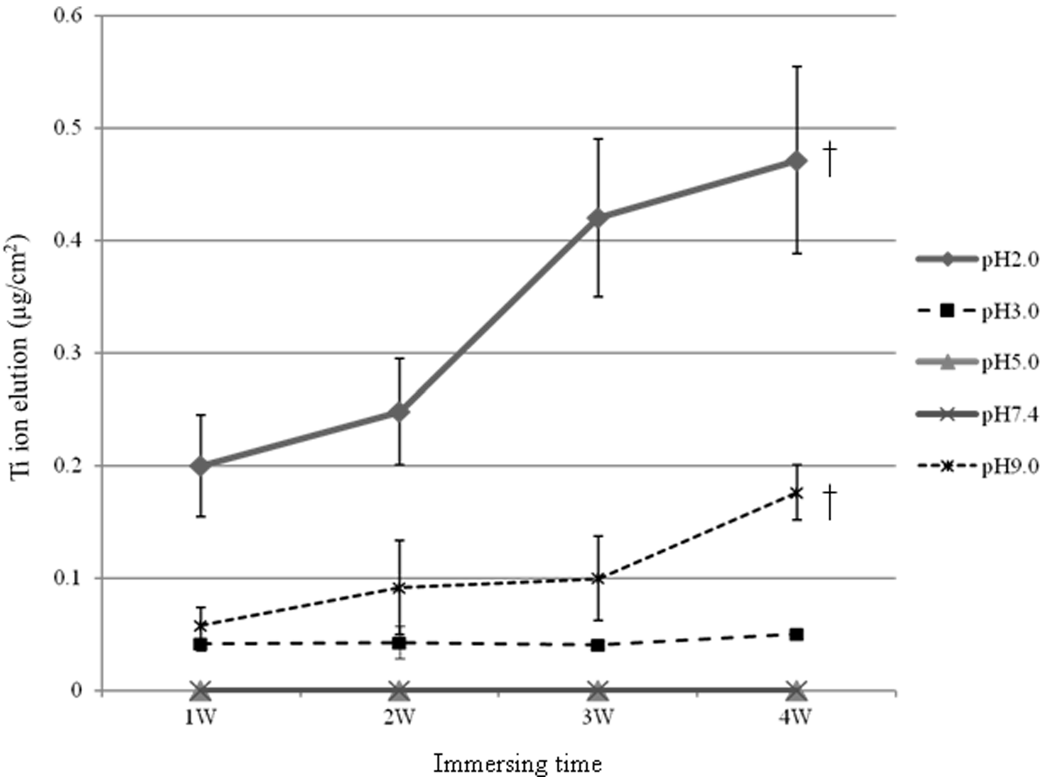
Figure 2. Effect of pH on Ti ion elution from specimens of CP Ti immersed in SBF solutions for 1 to 4 wk. { significant difference among the different immersion times.